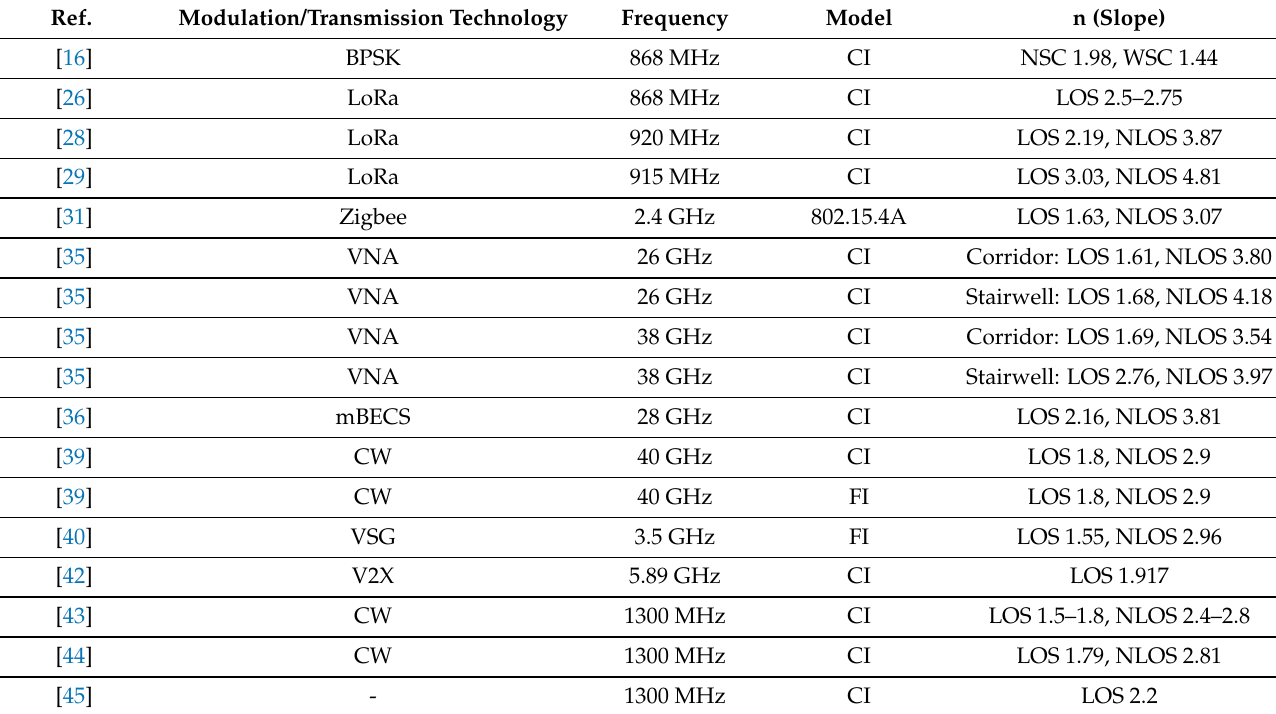
Table 1. Path loss measured in different